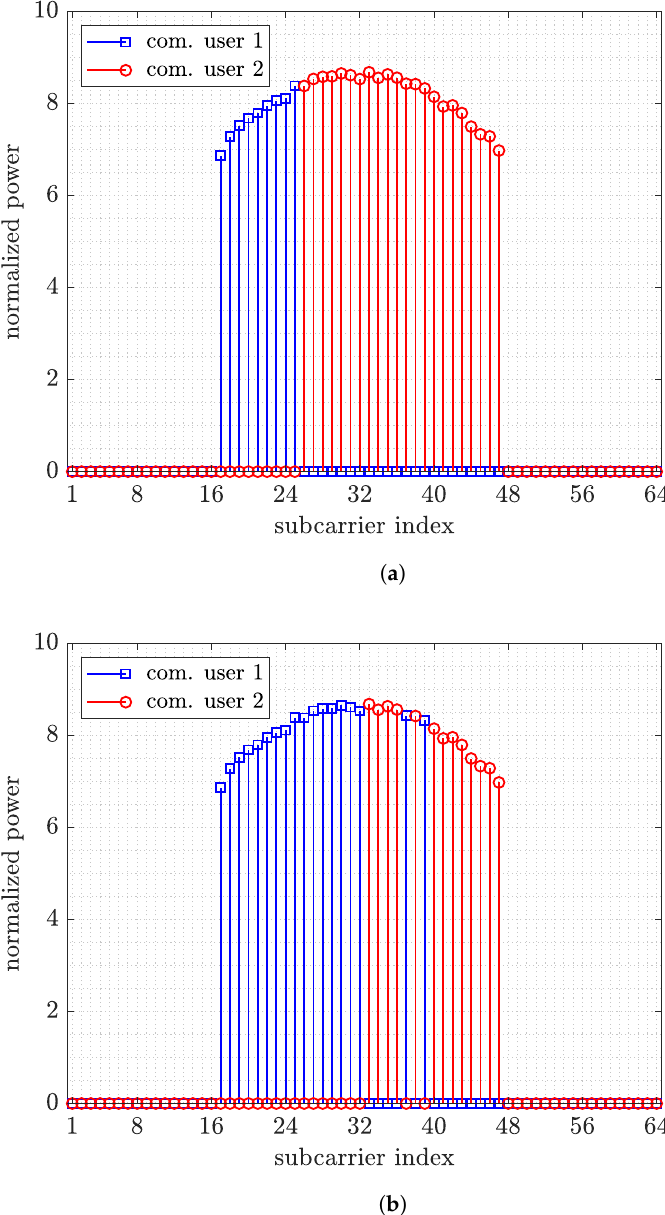
Figure 4. Radar-centric design for power allocation and subcarrier assignment. ( a ) Sum commu- nication MI maximization ( I ( y rad ; h | s ) = 31.56, I ( y com,1 ; g 1 | s ) = 12.67, I ( y com,1 ; g 2 | s ) = 18.27). ( b ) Worst-case communication MI maximization ( I ( y rad ; h | s ) = 31.56, I ( y com,1 ; g 1 | s ) = 13.16, I ( y com,1 ; g 2 | s ) =